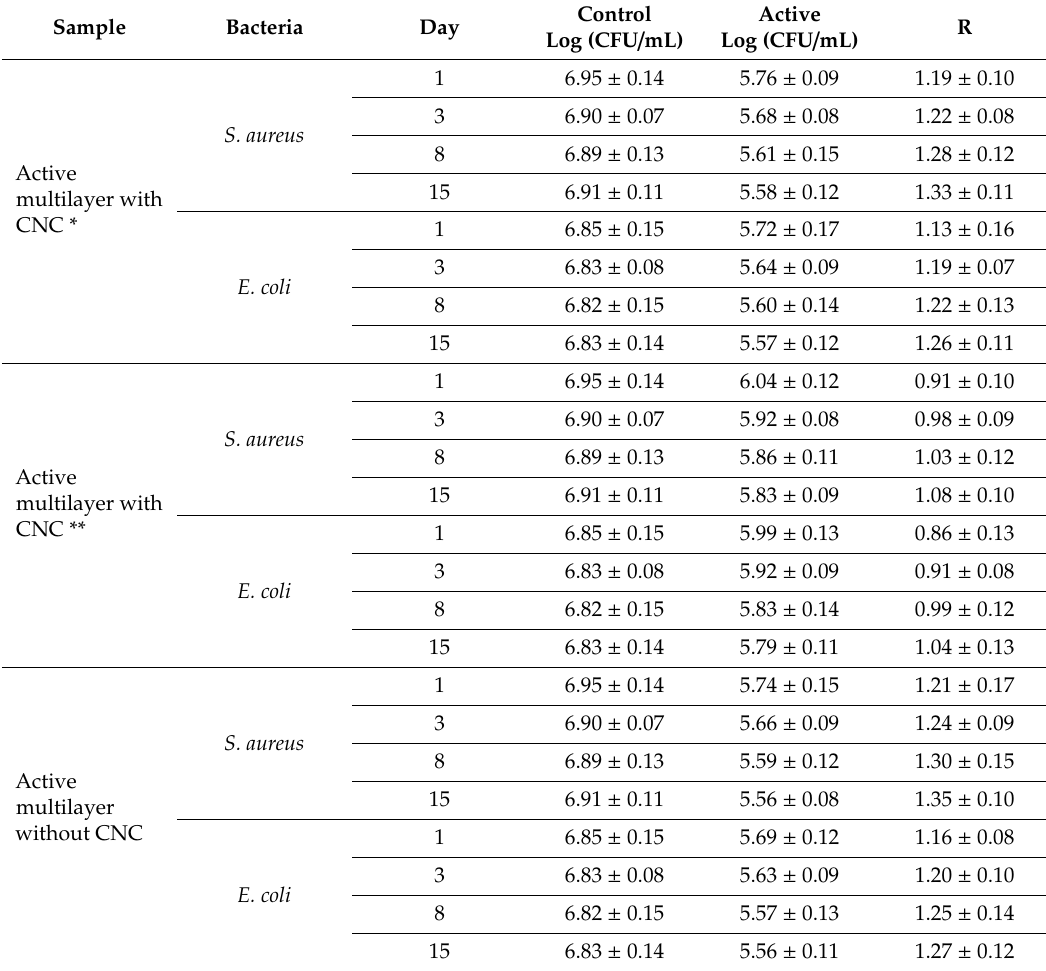
Table 4. Antibacterial activity against Staphylococcus aureus ( S. aureus ) and Escherichia coli (E. coli) of the active multilayer films with and without cellulose nanocrystal (CNC) coatings in the open system for 15